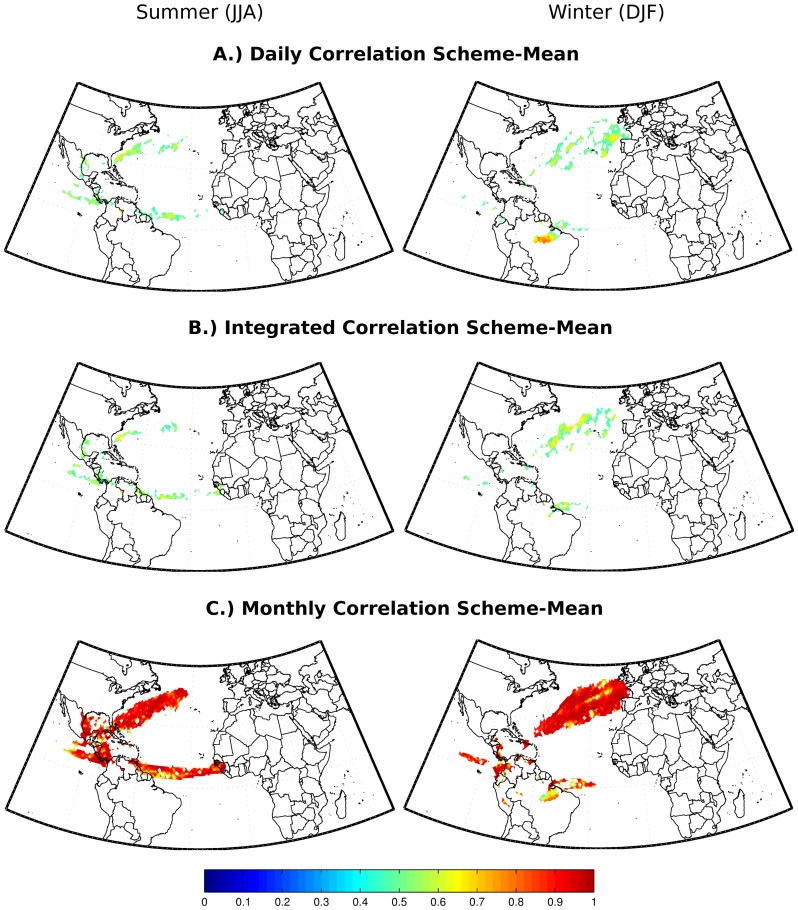
Pearson correlation of the 21-year of the net precipitation between the seasonal scheme-mean and the shorter time scale scheme-means (T test with 95% of significance).